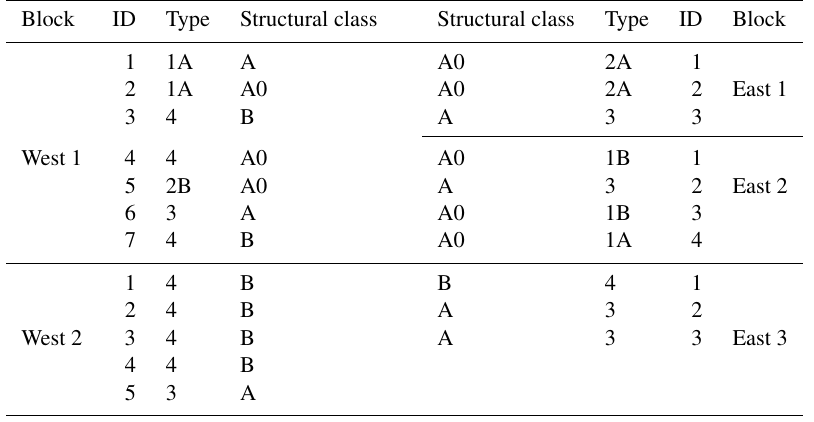
Table 2. Building types and simplified structural classes from Thouret et al. (2014). Typology Building